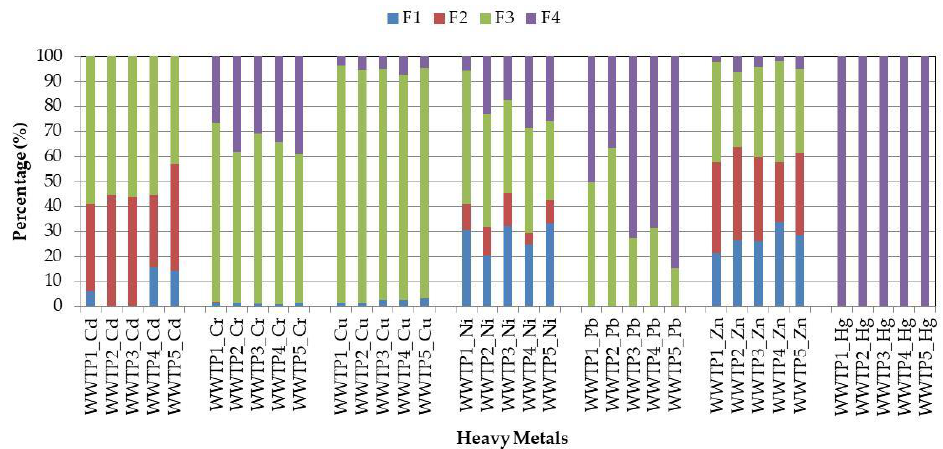
Figure 3. The average percentage distribution of each heavy metal fraction in the dewatered and/or hygienized sewage sludge samples (S2).